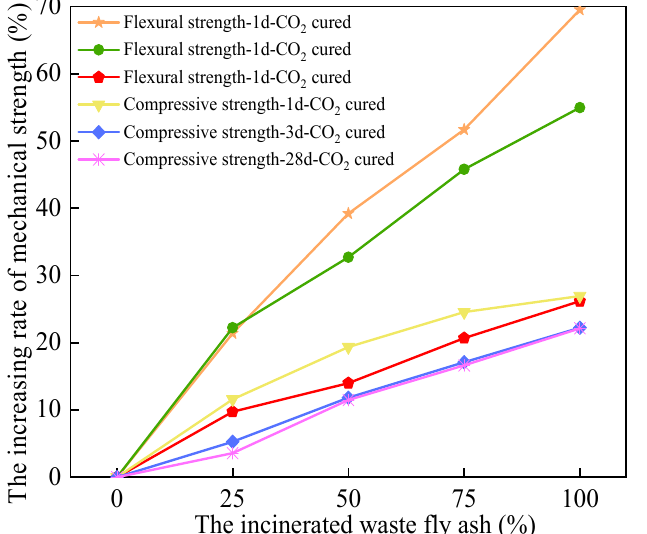
Figure 8. The increasing rates of mechanical strengths of RPC with CO 2 treated incinerated waste fly ash.